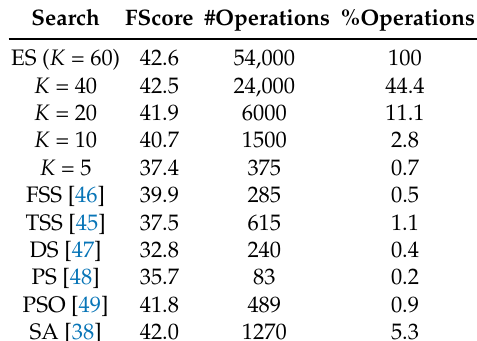
Table 8. Comparative results between different search approaches for threshold hypothesis selection, including regular sub-sampling patterns with sub-optimal subsets of thresholds K = { 40,20,10,5 } , non-regular sub-sampling patterns (TSS, FSS and DS) and more traditional global optimization approaches (PS, PSO, SA). Results in terms of FScore and computational cost (number and percentage of operations per each